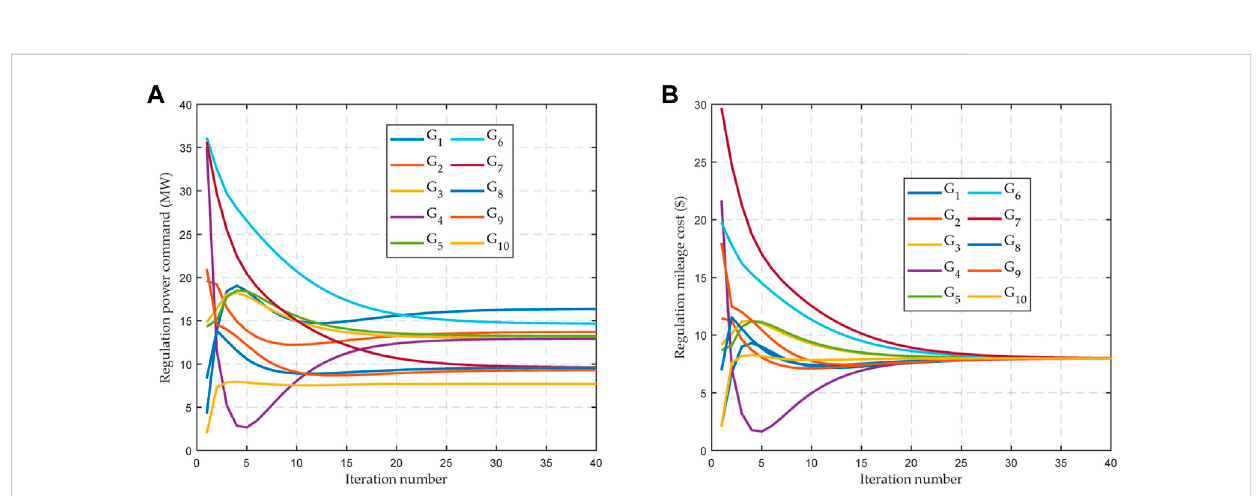
FIGURE 5 Local connected network test with a power dispatch command Δ P C (cid:2) 120MW for the DT-DPT system. (A) Optimal power command of regulation resources. (B) Optimal payment consensus process of the regulation resources.